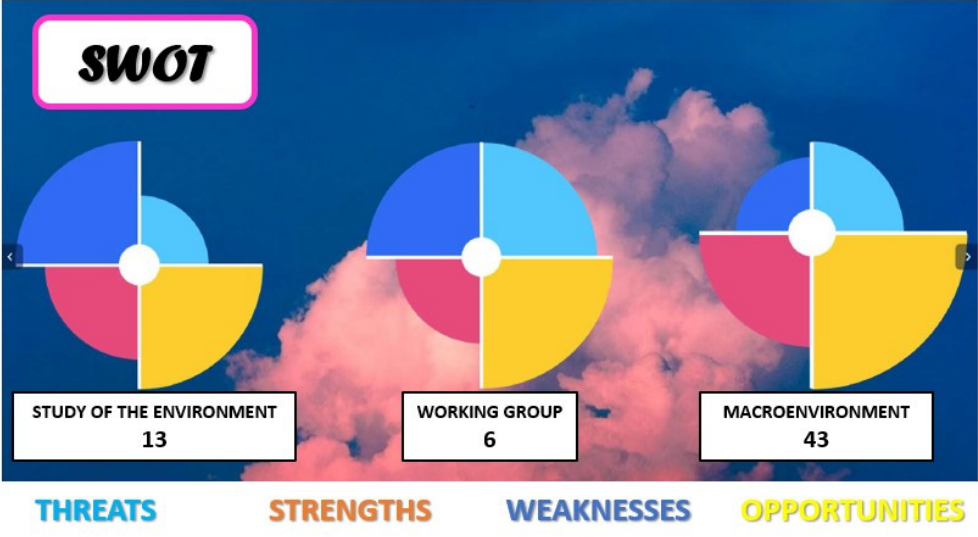
Figure 5. Elements included in weaknesses, strengths, threats and opportunities by colour code and radius size. Source: own elaboration.